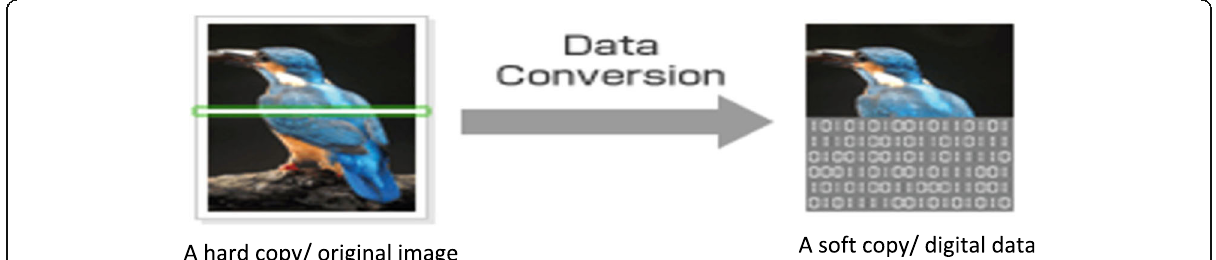
Fig. 2 Data conversion process for scanning